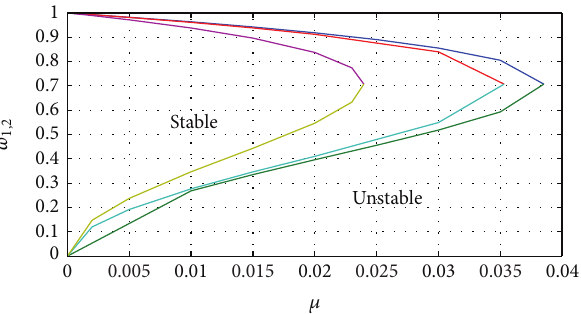
Figure 20: Combined graph for binary systems Kruger60-I, II, and III.